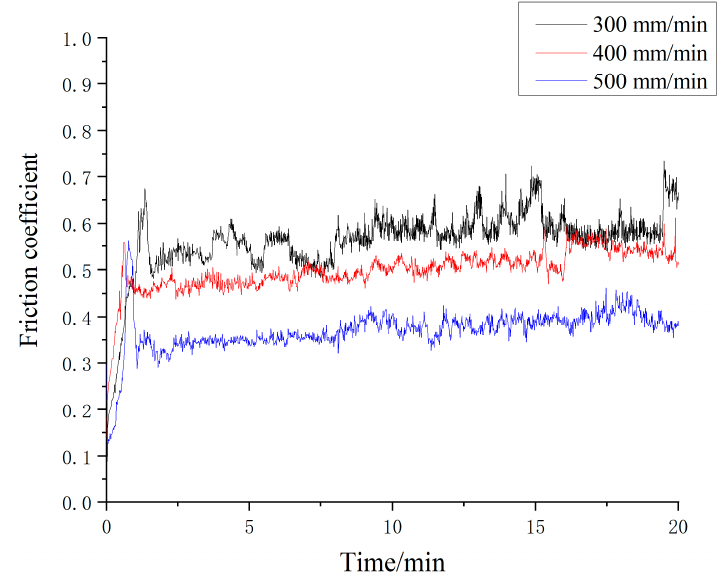
Figure 3. Variation of the friction coefficient.